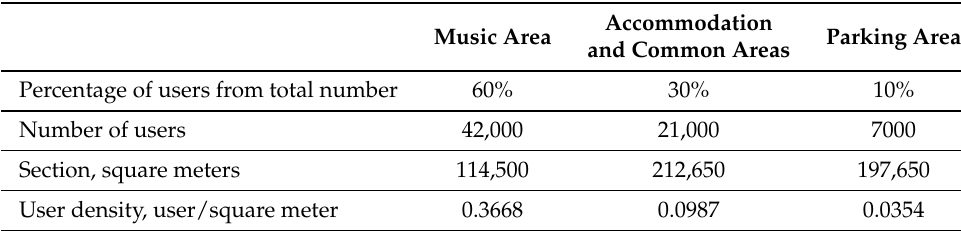
Accommodation Music Area and Common